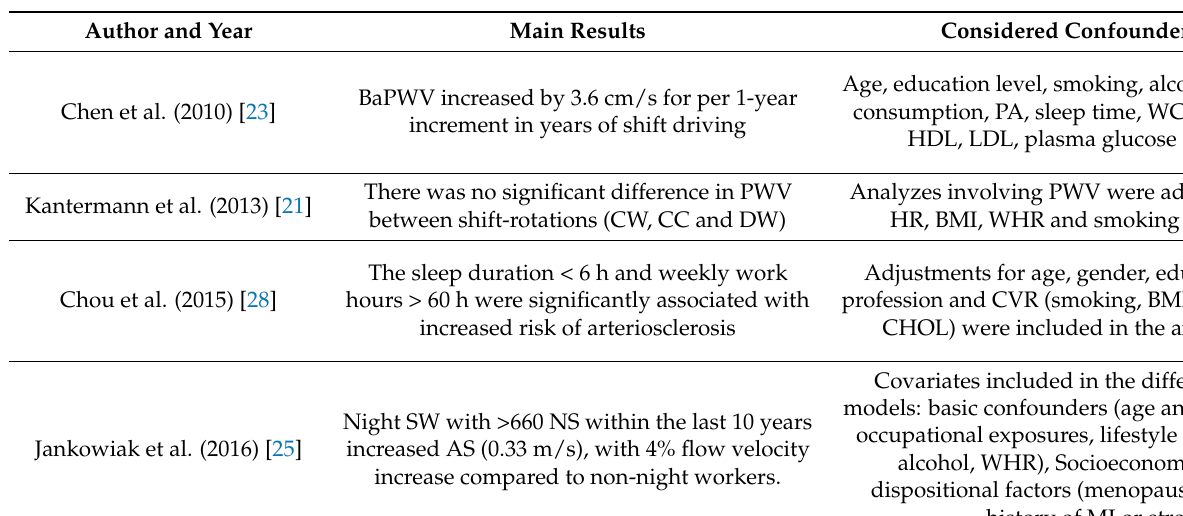
Table 5. Systematization of main results, confounder, covariate selection, and limitations of the